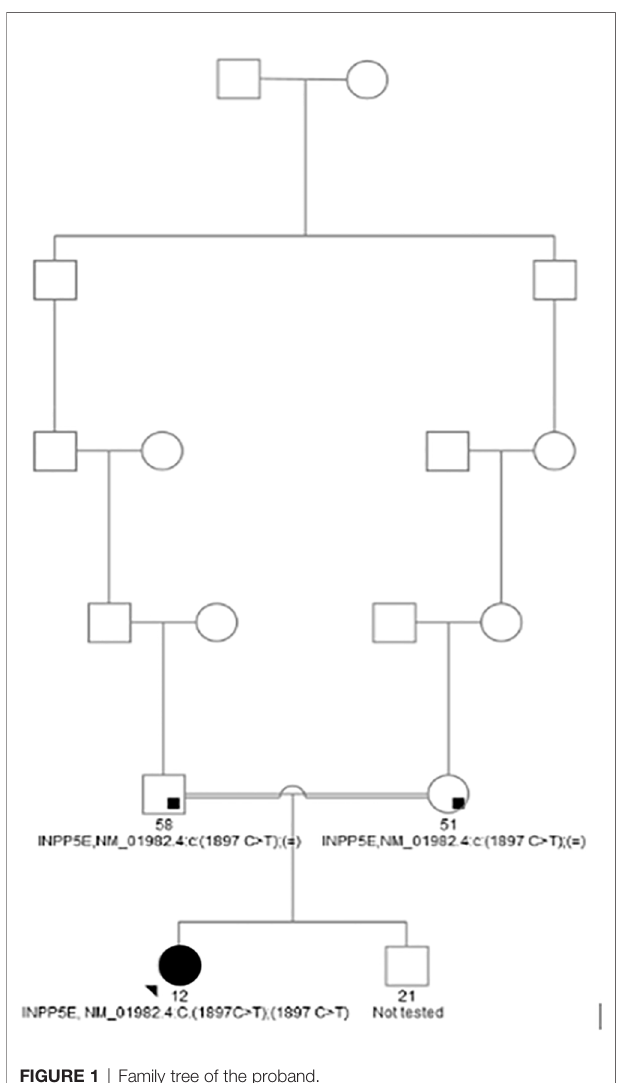
FIGURE 1 | Family tree of the